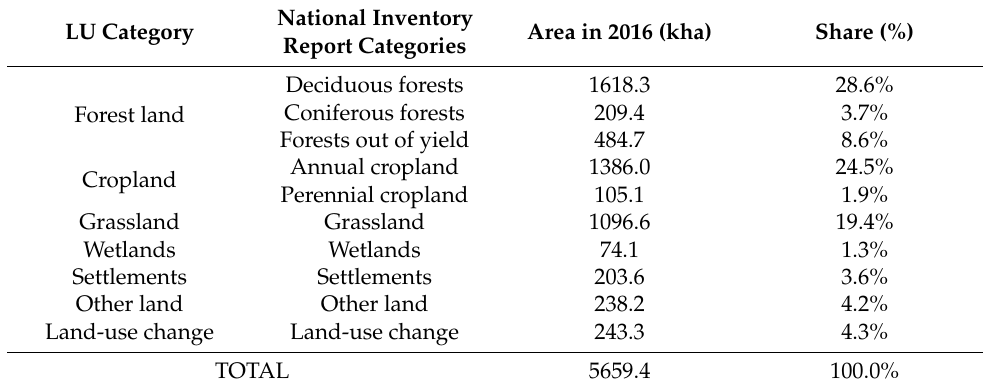
Table 1. Area of land-use categories in Republic of Croatia in 2016 according to HR NIR 2020 [59].